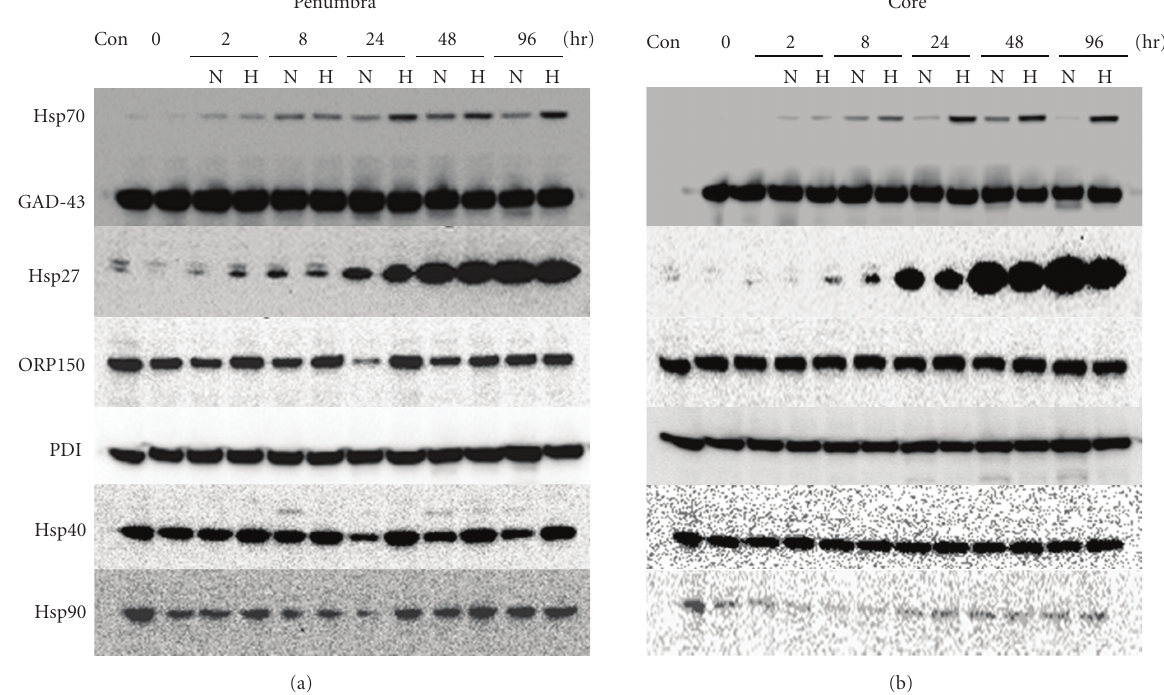
Figure 3: E ff ect of occlusion of the middle cerebral artery (MCAO) and hypothermia on chaperones expression in rat brains. Western blot analysis for Hsp70, Hsp27, Hsp40, Hsp90, ORP150, PDI, and GAD-43 was performed using protein samples from the penumbra and core regions of rat ischemic brains at the indicated time points after reperfusion. GAD43 protein served as an internal control. N: normothermia, H: hypothermia. “Con” denotes protein samples from normal rat brains. The procedure used has been previously described